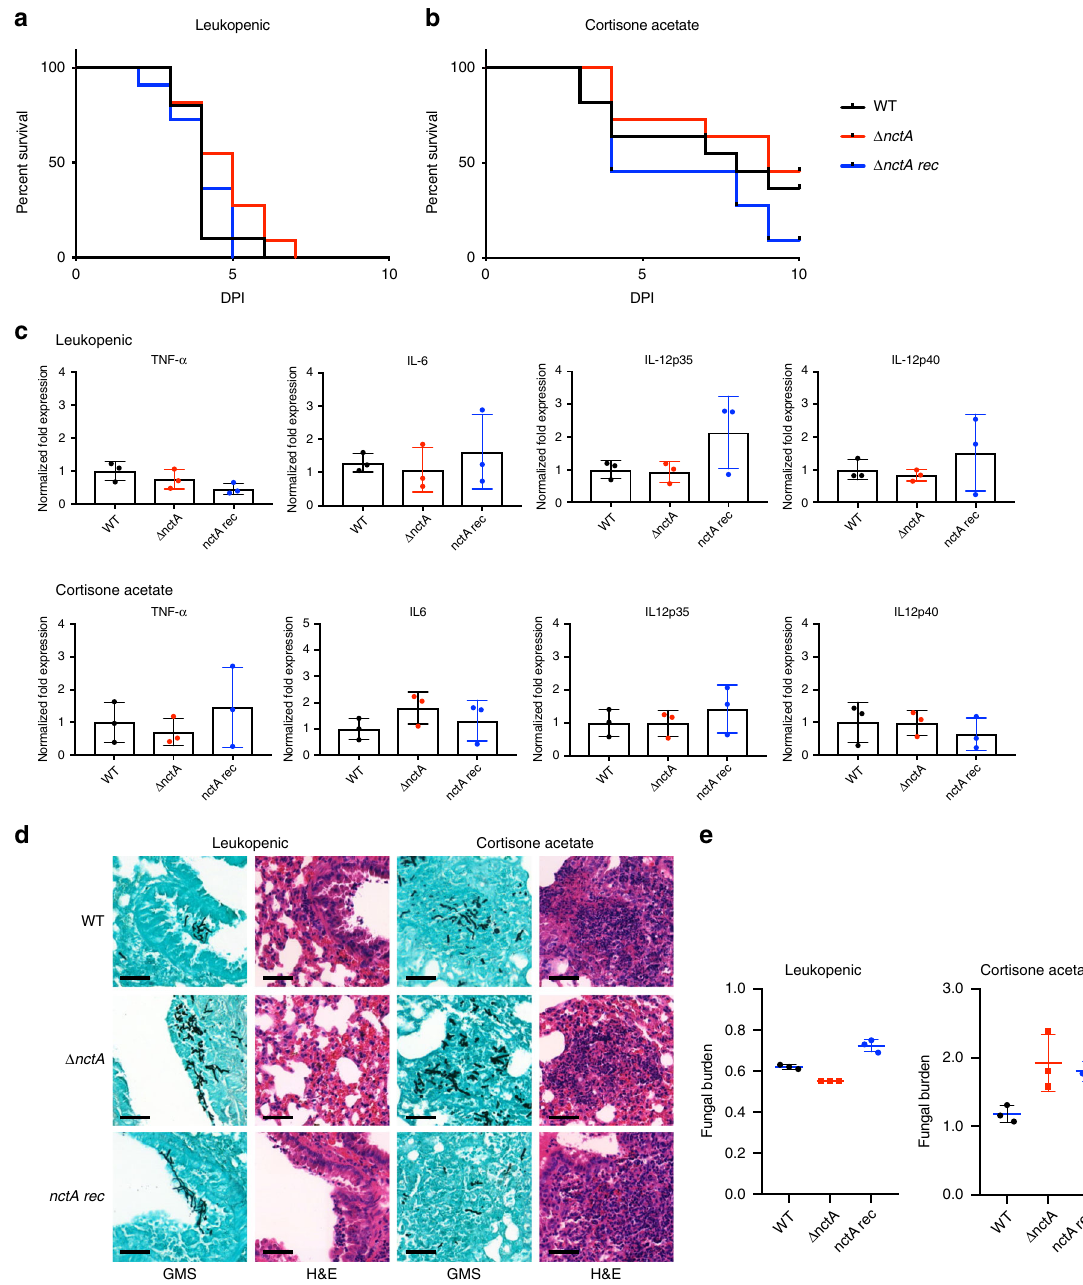
Fig. 8 Assessing the effect of loss of nctA on the virulence of A. fumigatus in murine infection models. Mice were infected with the wild-type (WT), the nctA null mutant ( Δ nctA ) or the reconstituted isolate ( nctA rec ). a , b Kaplan – Meier curve for murine survival for mice treated via ( a ) intranasal infection with 5.0 × 10 5 conidia after mice were rendered neutropenic by treatment with cyclophosphamide, and ( b ) intranasal infection with 7.0 × 10 6 conidia after cortisone acetate treatment. A log rank analysis was used to compare the results between the strains. c Relative expression levels of proin fl ammatory cytokines in the infected lung tissues. Data represent the mean of biological triplicates and error bars illustrate the standard deviation. Statistical signi fi cance was calculated by Student ’ s t test. d Histopathology of representative sections of lungs after 36 h post infection with WT, Δ nctA , or nctA rec . Lung sections were stained with haematoxylin – eosin (H&E) for visualisation of the host cells, and Grocott ’ s Methenamine Silver (GMS) for visualisation of the fungal elements. Scale bar: 50 µ m. e Quanti fi cation of the fungal burden in the infected lungs. The total genomic DNA was extracted from the same lung lobe samples used for the cytokine expression analysis, and fungal DNA concentration was determined by qPCR. Data represent the means of biological replicates, and the error bars mean standard deviation. The statistical signi fi cance of variances between fungal burdens was calculated by using a non-parametric Mann – Whitney t test. Source data are provided as a Source Data fi